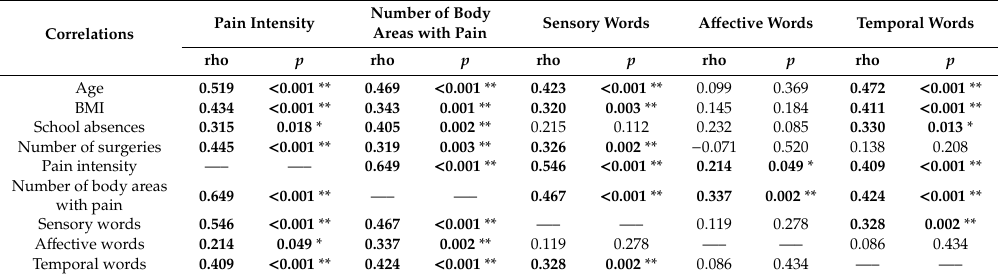
Table 5. Correlation analysis between components of the Adolescent Pediatric Pain Tool (APPT) with several